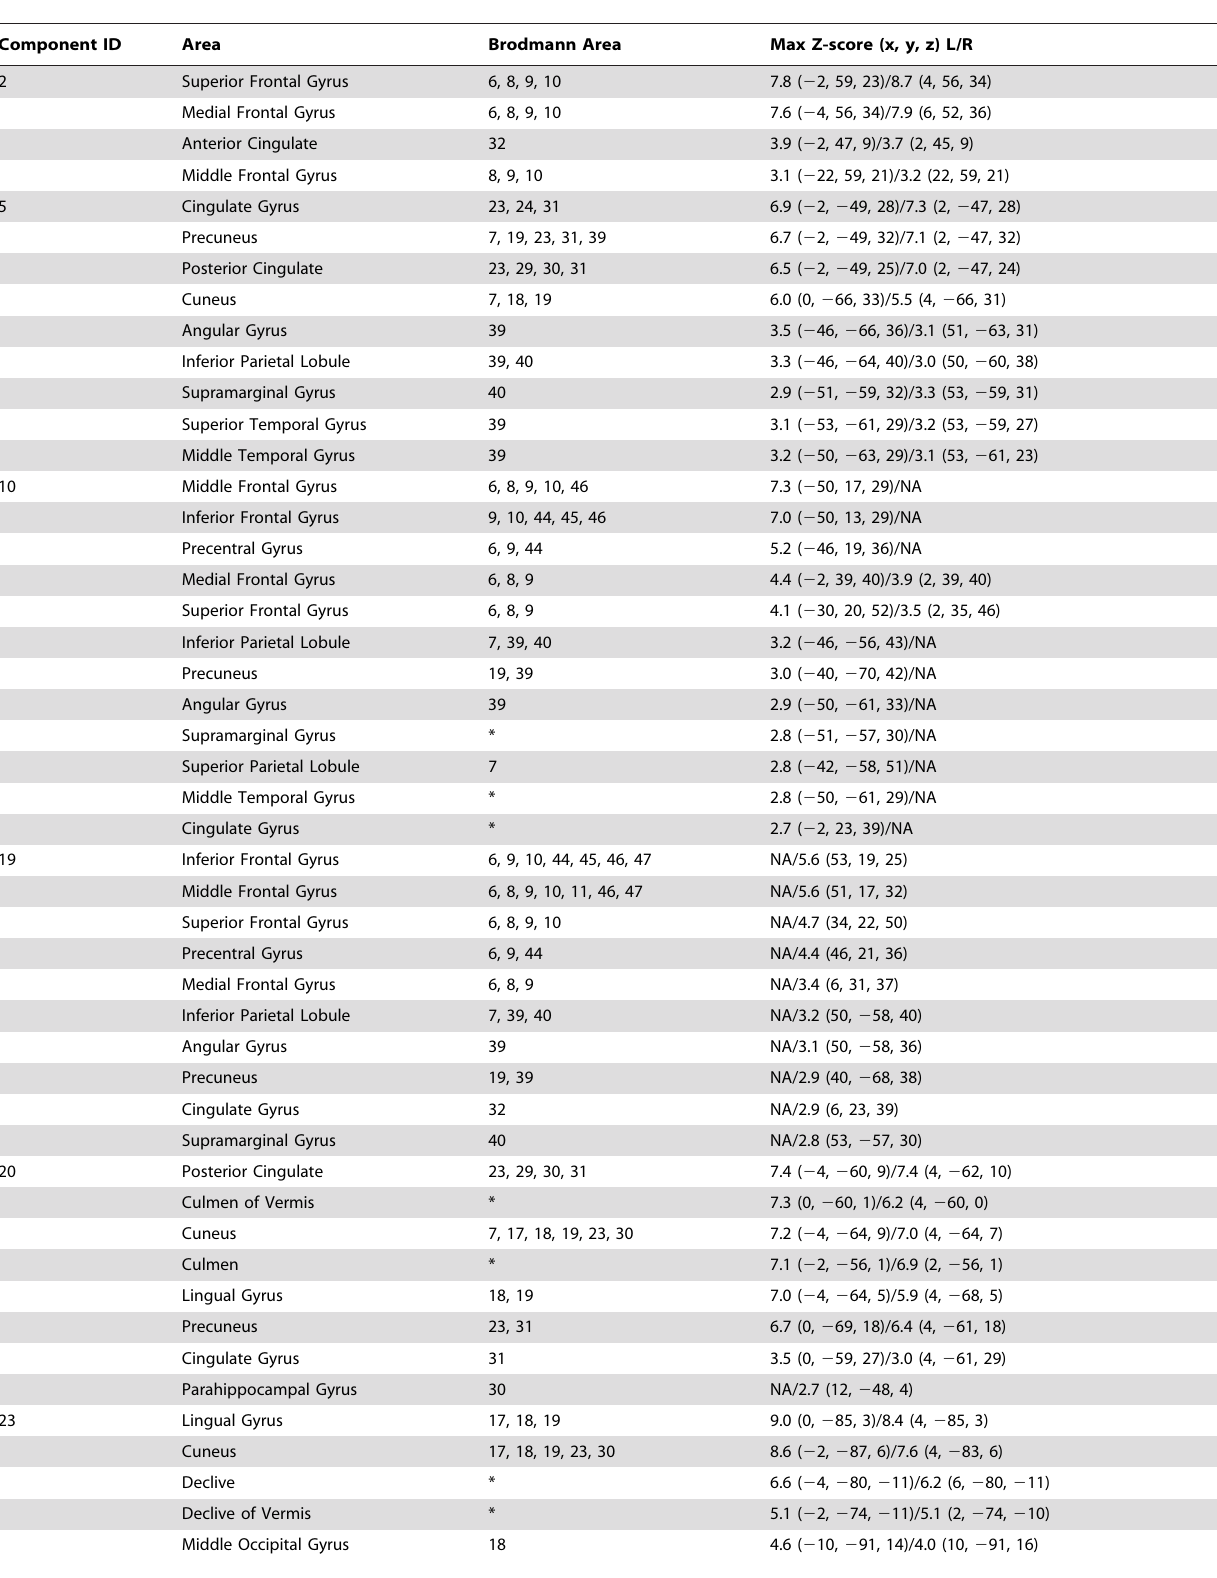
Table 1. Cortical localizations of the 10 task-related independents components: for each component we presented the anatomical location, corresponding Brodmann area(s), and the maximum Z-score with its Talairach coordinates (obtained using the Talairach utility provided in GIFT toolbox on group-ICA components